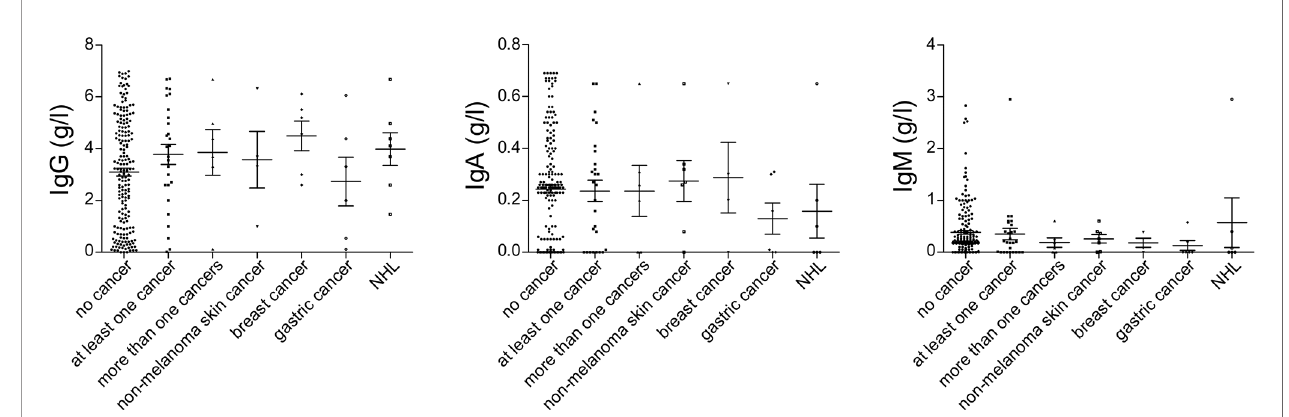
FIGURE 1 | Serum immunoglobulin levels at diagnosis of common variable immunode fi ciency (CVID), prior to the introduction of immunoglobulin replacement, in patients with no cancer ( N = 192), patients with at least one cancer ( N = 27), more than one type of cancer ( N = 6), non-melanoma skin cancer ( N = 7), breast cancer ( N = 7), gastric cancer ( N = 6), and non-Hodgkin lymphoma (NHL, N = 6). No signi fi cant differences could be